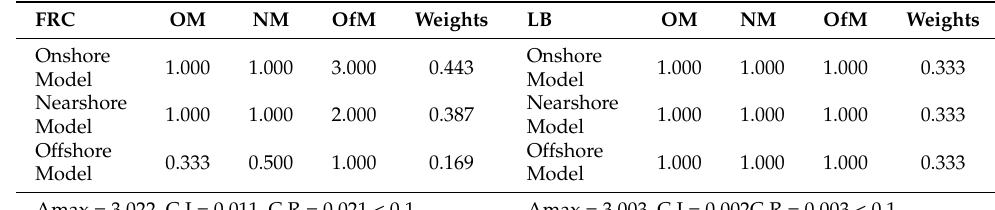
Table 11. Weights of the alternatives with respect to frequent requirement changes and language